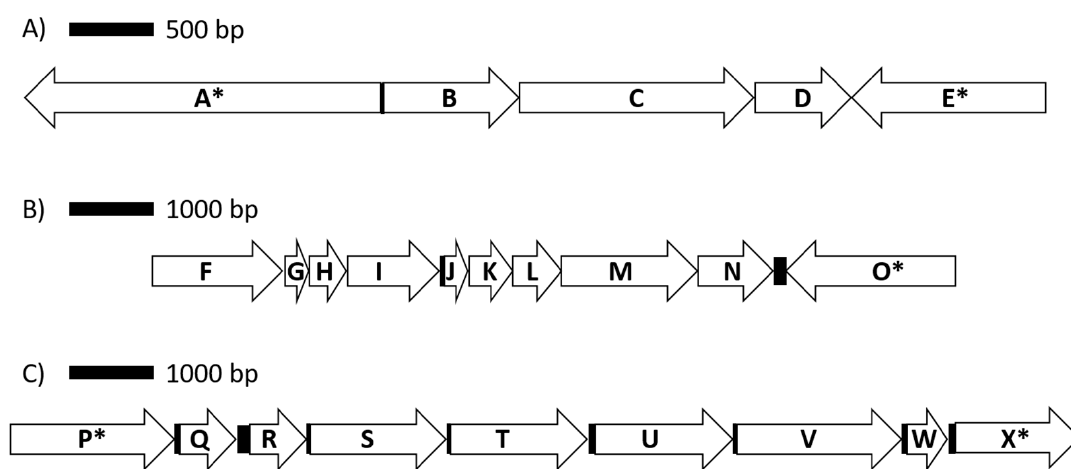
Figure 3. Genomic organization for genes encoding proteins involved in lactate utilization ( A ), the ATP synthase complex ( B ) and arabinose metabolism ( C ). Coding sequences are represented by arrows, while intergenic regions are shown as solid boxes. Available contig sequences permitting, genes flanking coding sequences of interest are indicated by (*). Annotated protein / enzymes displayed are (A) DNA topoisomerase; (B) L-lactate dehydrogenase, Fe-S oxidoreductase; (C) lactate utilization domain protein; (D) lactate utilization domain protein; (E) DegT / DnrJ / EryC1 / StrS aminotransferase family; (F) F0F1 ATP synthase subunit beta; (G) F0F1 ATP synthase subunit epsilon; (H) hypothetical protein; (I) F0F1 ATP synthase subunit A; (J) F0F1 ATP synthase subunit C; (K) F0F1 ATP synthase subunit B; (L) F0F1 ATP synthase subunit delta; (M) F0F1 ATP synthase subunit alpha; (N) F0F1 ATP synthase subunit gamma; (O) fructose 1,6 bisphosphatase; (P) sodium solute symporter; (Q) nudix hydrolase; (R) L-ribulose-5-phosphate 4-epimerase; (S) L-arabinose isomerase; (T) FGGY-family carbohydrate kinase; (U) alpha-N-arabinofuranosidase; (V) transketolase; (W) ribose 5 phosphate isomerase; (X) pyruvate